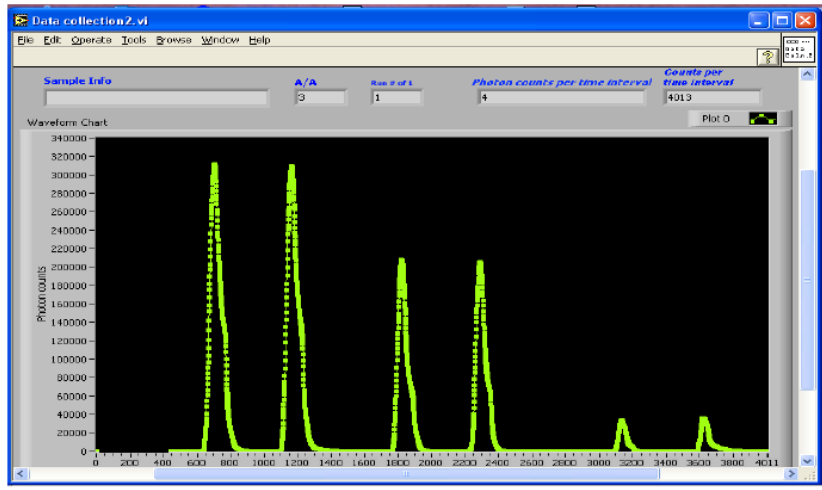
Figure 5. Typical FI toxicity assessment diagram. Horizontal axis: time (s), Vertical axis: Bioluminescence Intensity (PMT counts). Peaks from left to right: blank (1st and 2nd), Cu 2+ solution 3.0 mM (3rd and 4th ) and 10.0 mM (5th and